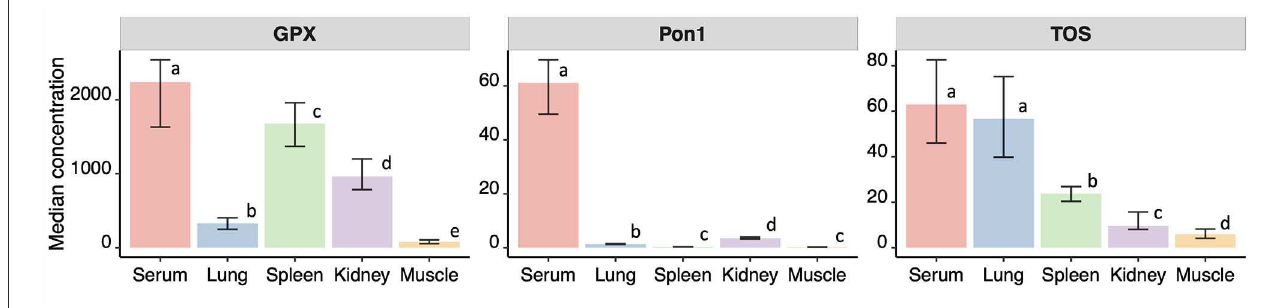
FIGURE1 Median and confidence intervals of the median (in brackets) concentrations of p-nitrophenyl esterase activity (EA, in IU/ml), paraoxonase 1 (PON1, in IU/ml) in serum, glutathione peroxidase (GPX, in IU/L), and TOS (total oxidative status, in µ mol/L) measured in serum, lung, spleen, kidney and muscle from 63 wild boars hunter-harvested in Toledo, Central Spain. Different letters indicate significant differences in pairwise comparisons at alpha = 0.05.